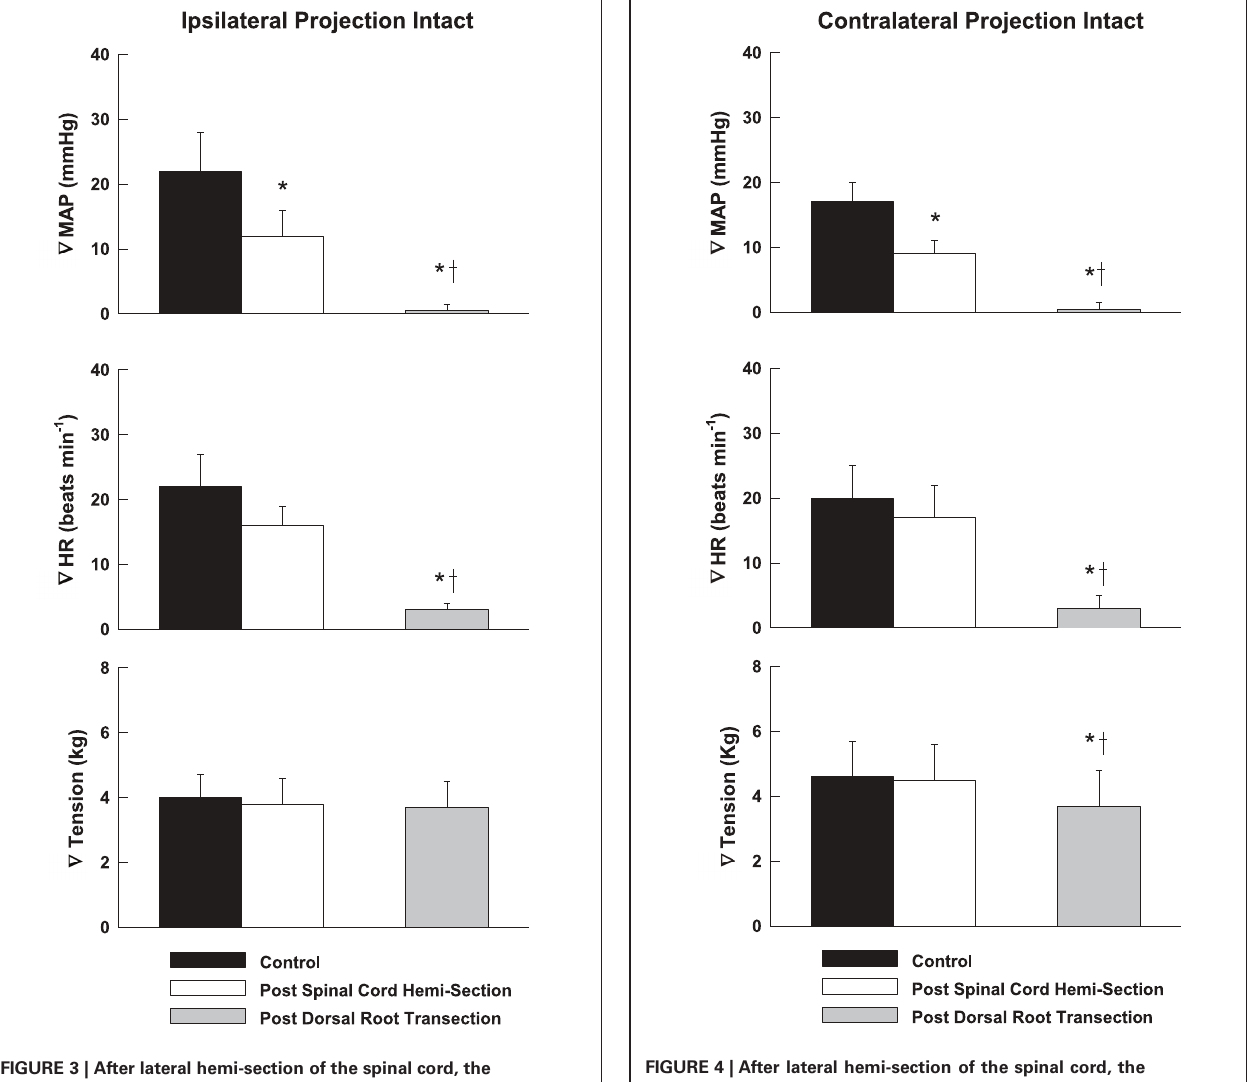
FIGURE 4 | After lateral hemi-section of the spinal cord, the exercise-induced increases in MAP were attenuated compared to control when contracting the leg ipsilateral to the lesion (contralateral sensory projection intact). HR responses were largely unaffected. Sectioning the dorsal roots innervating the activated hindlimb skeletal muscle almost completely abolished the cardiovascular response to exercise. Asterisk indicates significantly different from control condition. Cross indicates significantly different from spinal cord hemi-section condition ( P < 0 .